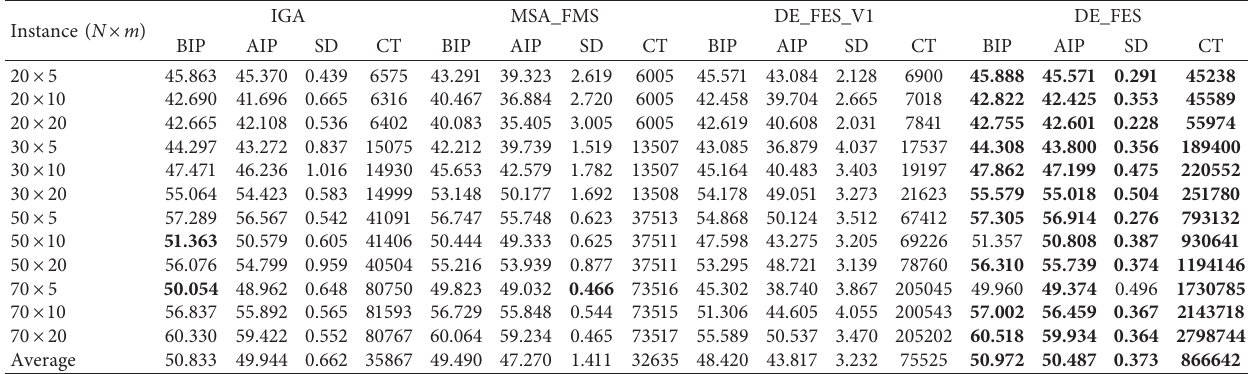
Table 1: Comparison results of four algorithms.